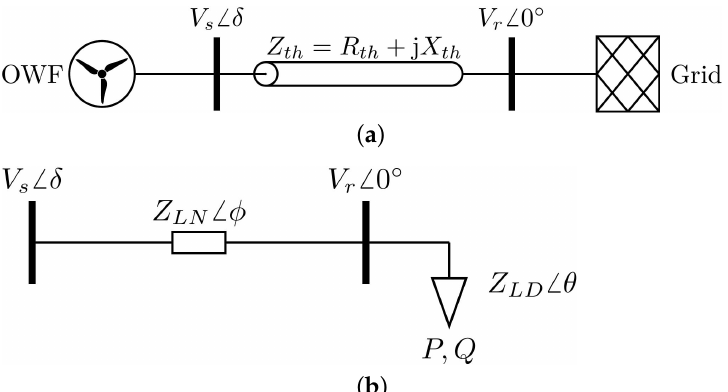
Figure 2. Network equivalents of an aggregated OWF for the PQV analysis. ( a ) Simplified single-line diagram of a transmission network of an OWF connected to the grid via a Thevenin impedance of the OWF. ( b ) Essential network equivalents for the network